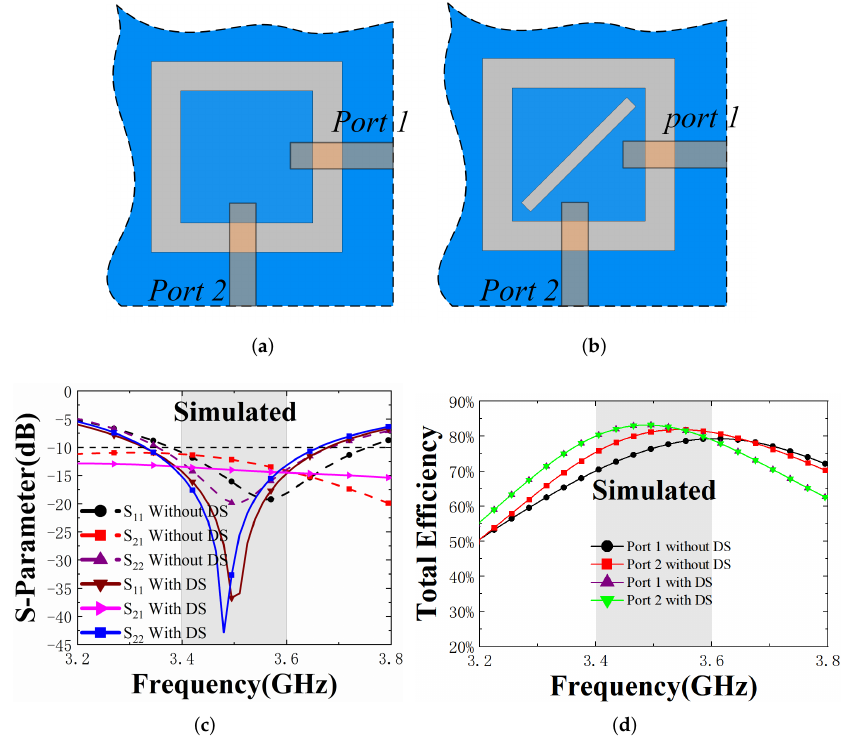
Figure 2. Evolution steps of the proposed elements. ( a ) Without diagonal slot. ( b ) With diagonal slot. ( c ) Simulated S-Parameter. ( d ) Simulated TE.